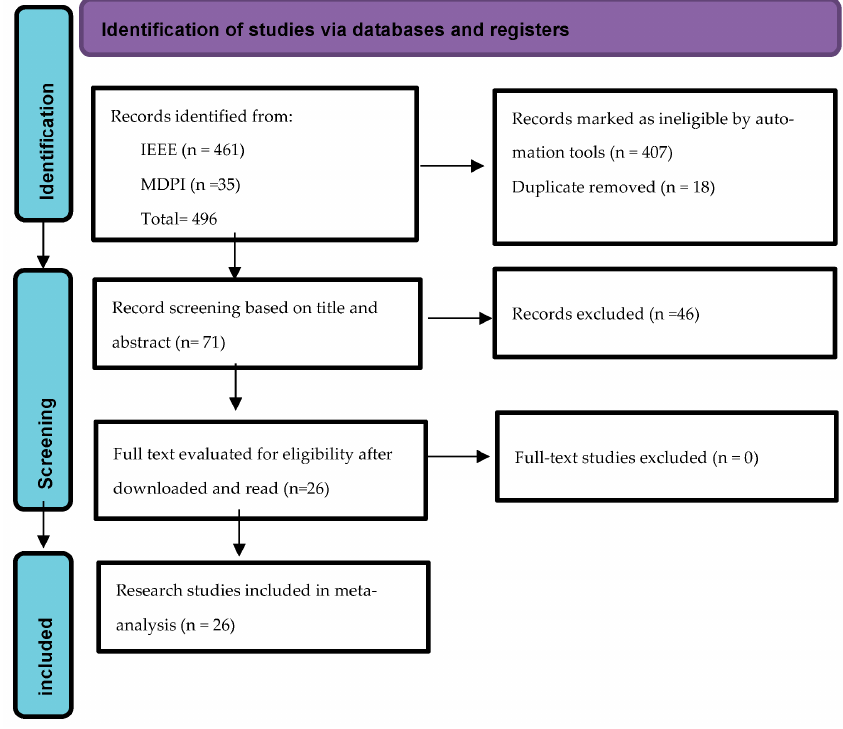
Figure 1. PRISMA flow diagram of the study selection process.